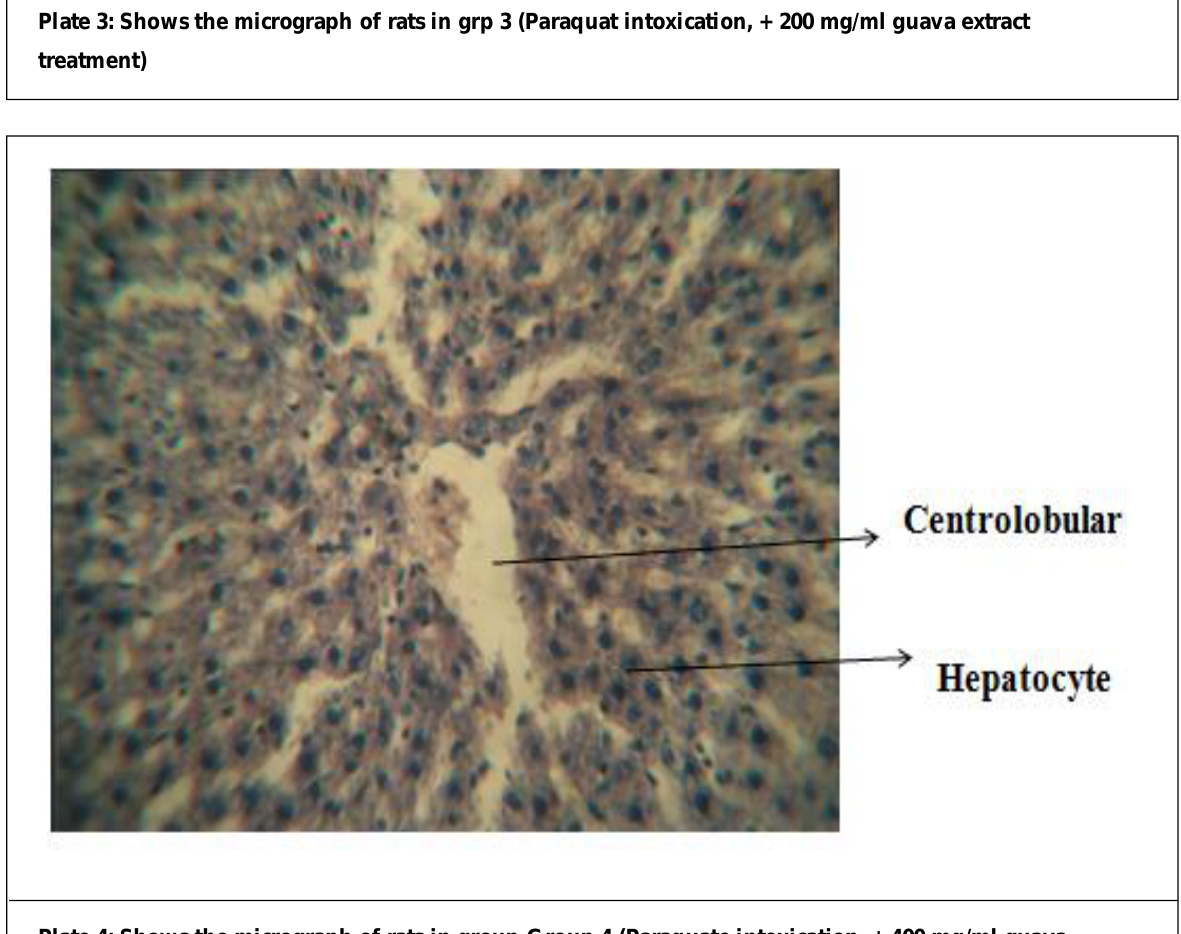
Plate 4: Shows the micrograph of rats in group Group 4 (Paraquate intoxication, + 400 mg/ml guava extract